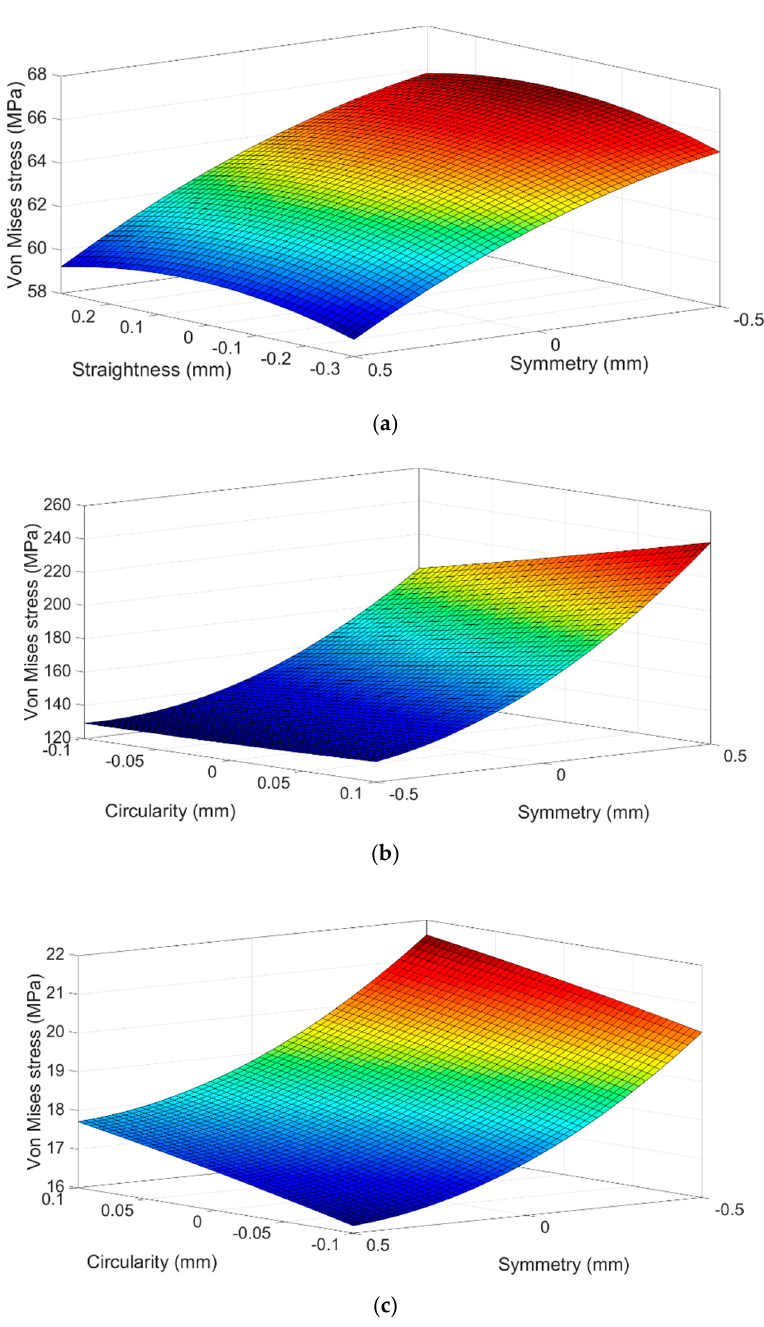
Figure 16. Response surface based on the geometric tolerance for the rosette zone: ( a ) #1, ( b ) #2 and ( c ) #3.